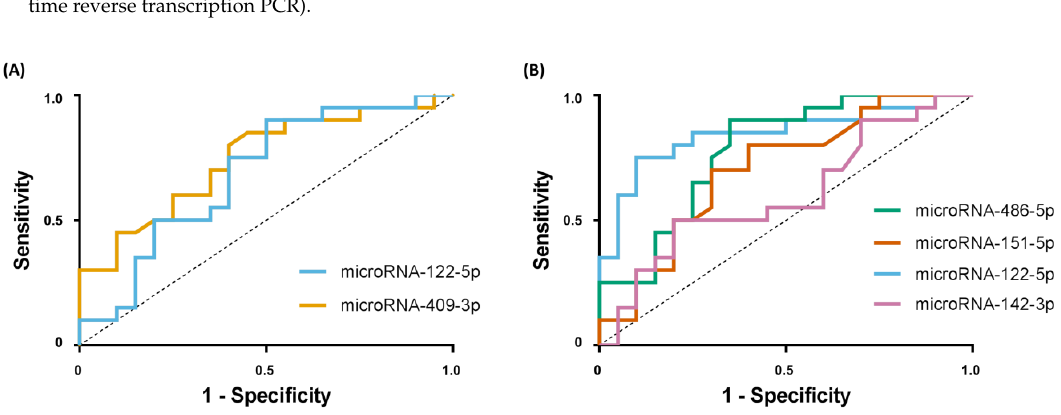
Figure 2. ROC curves for individual serum miRNAs to identify cirrhosis or HCC in chronic hepatitis C ( A ). ROC curve performance of miRNA-122-5p with AUC of 0.69 (95% CI 0.51–0.86, p = 0.023) and miRNA-409-3p with AUC of 0.74 (95% CI 0.58–0.90, p = 0.004) to identify cirrhosis when